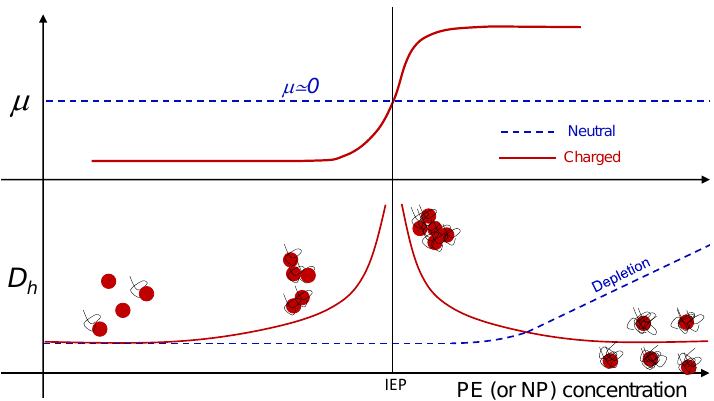
Figure 1. Representative sketch of electrophoretic mobility ( µ ) and hydrodynamic diameter ( D h ) behavior when suspensions of neutral (dashed lines) and charged (continuous lines) colloids are progressively “contaminated” by small polymers or nanoparticles, whose charge is opposite to that of the colloids, when the latter also bear a non-zero net charge. Neutral colloidal particles are subject to a progressive clustering when depletion attractions dominate over thermal energy [43], while their nearly zero mobility stays unaffected by depletant addition. Conversely, when charged polyelectrolytes or nanoparticles are added to a suspension of oppositely charged colloids both mobility reversal and reentrant condensation